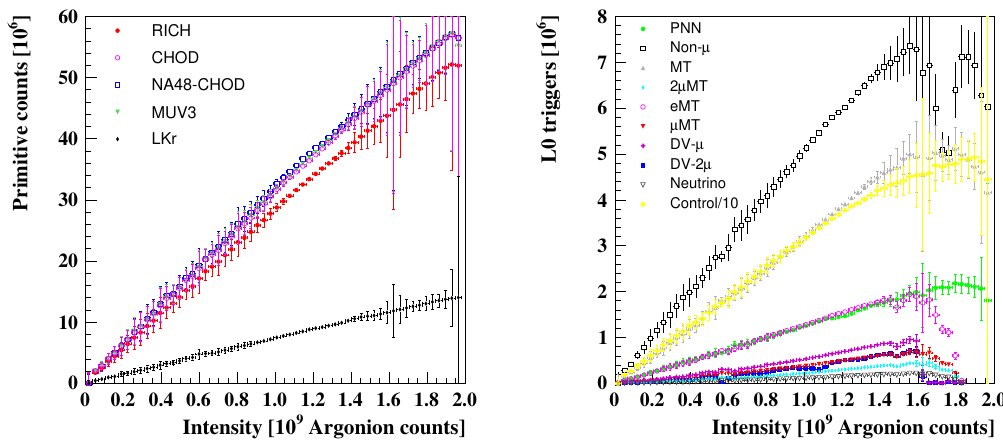
Figure 3. Number of primitives (left) and L0 triggers before downscaling (right) per spill as a function of the average beam intensity. Local variations in the data distributions are within statistical uncertainties.